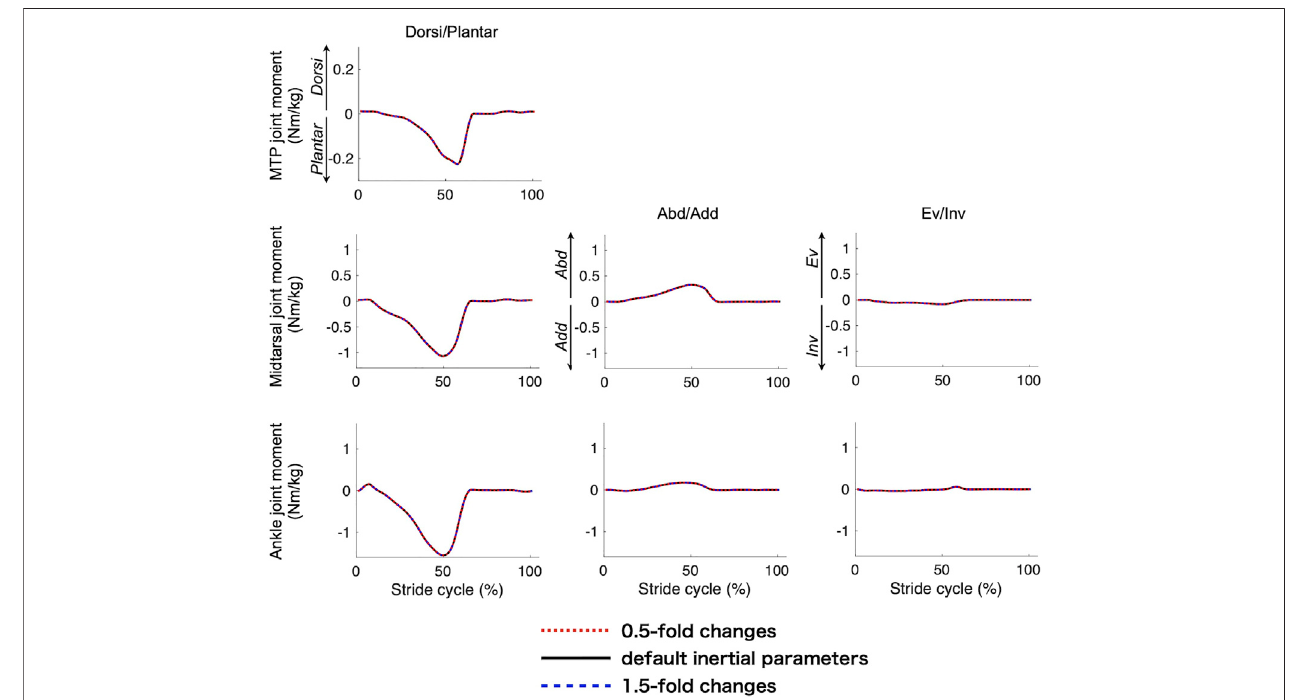
FIGURE 7 | Comparisons of the mean joint moment pro fi les when the inertial parameters were altered.